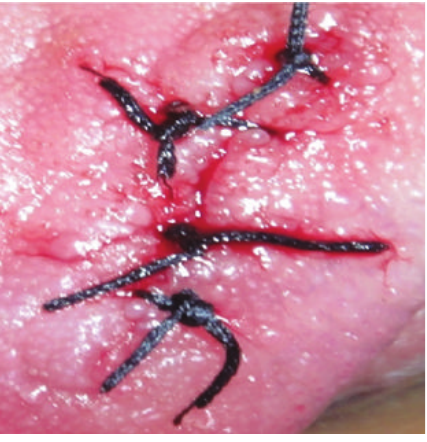
Figure 5: Interrupted sutures